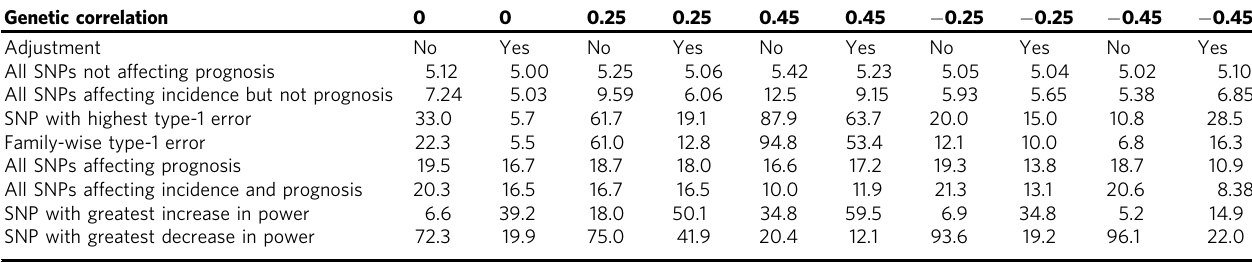
Table 1 Power for quantitative incidence and prognosis with non-genetic confounding Genetic correlation